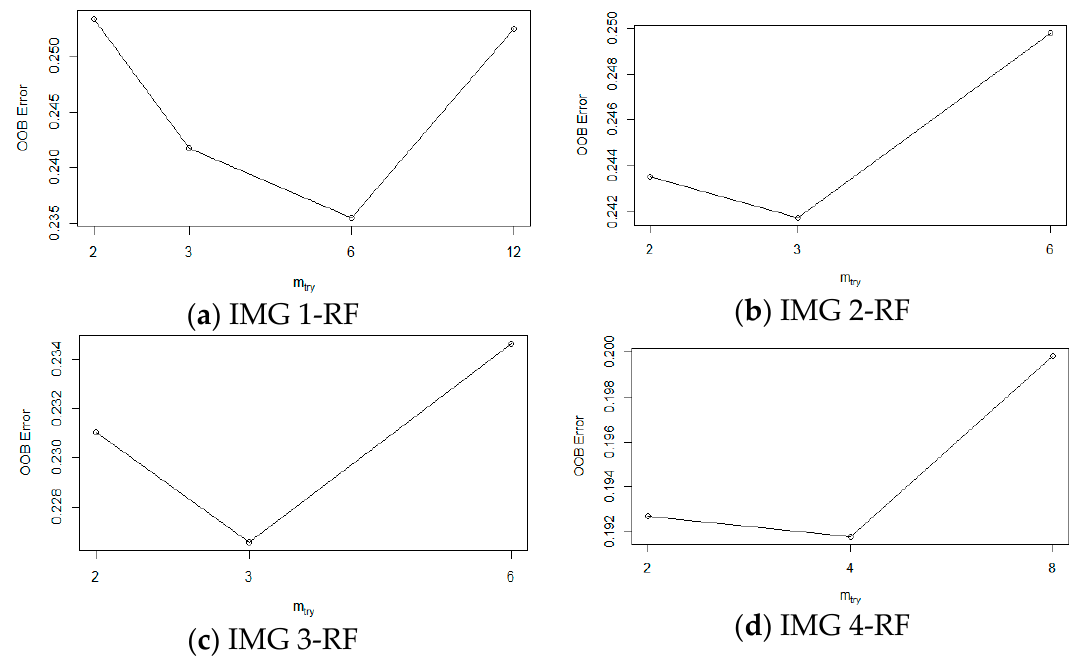
Figure 6. The OOB error of the model based on mtry parameter: IMG 1-RF; ( b ) IMG 2-RF; ( c ) IMG 3-RF; ( d ) IMG 4-RF.